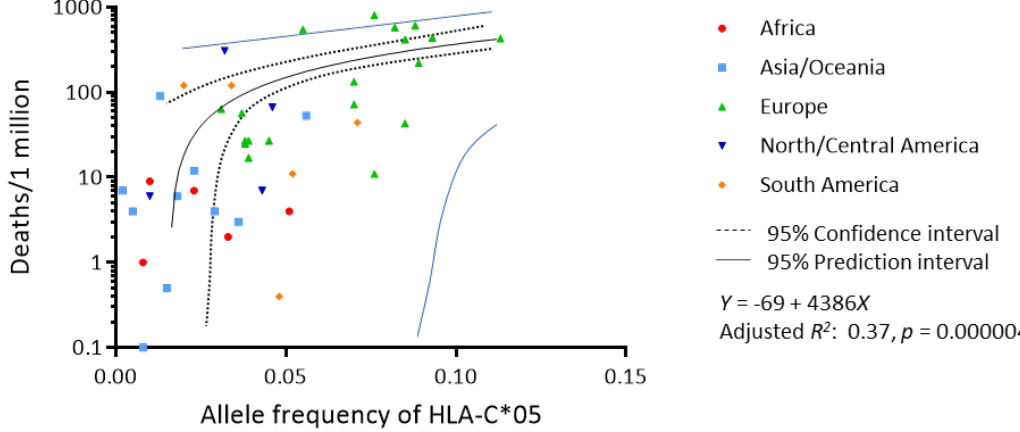
Figure 1. Worldwide allele frequency of HLA-C*05 and risk of deaths due to COVID-19. Linear regression showed a strong correlation between the allele frequency of HLA-C*05 and number of deaths per 1 million population (adjusted R 2 0.37, p = 0.0000047).